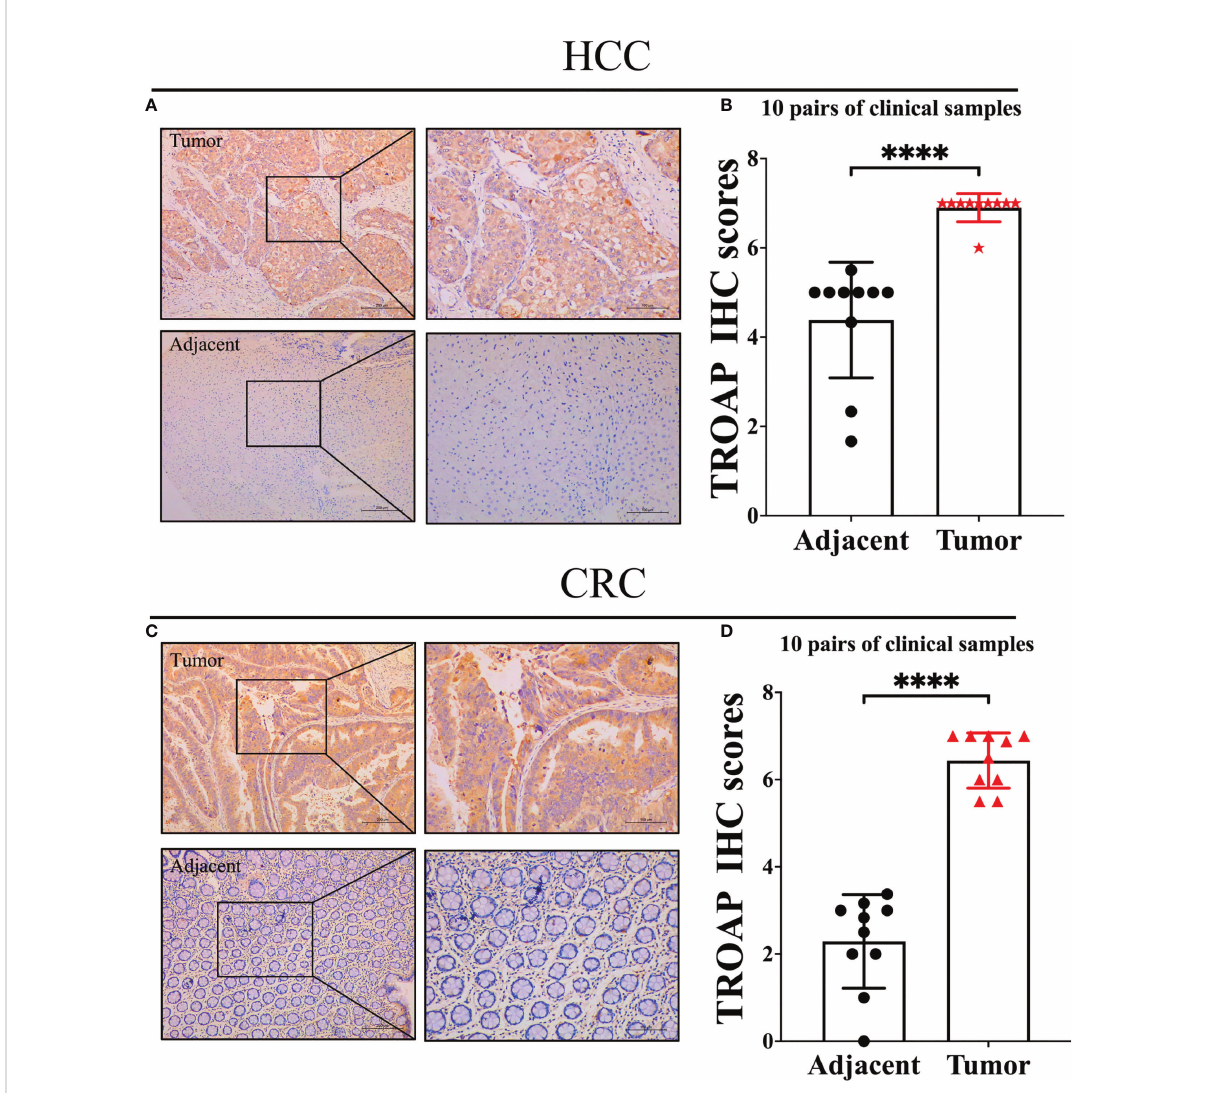
FIGURE 3 Representative immunohistochemical staining in tumor and tumor-adjacent normal tissue. (A) TROAP staining score was statistically higher in HCC tissues compared to adjacent tissues; (B) Statistical analysis of immunohistochemical staining intensity of HCC group and adjacent group (n=10, p<0.0001); (C) TROAP staining score was statistically higher in CRC tissues compared to adjacent tissues; (D) Statistical analysis of immunohistochemical staining intensity of CRC group and adjacent group (n=10, p<0.0001). ****:P <